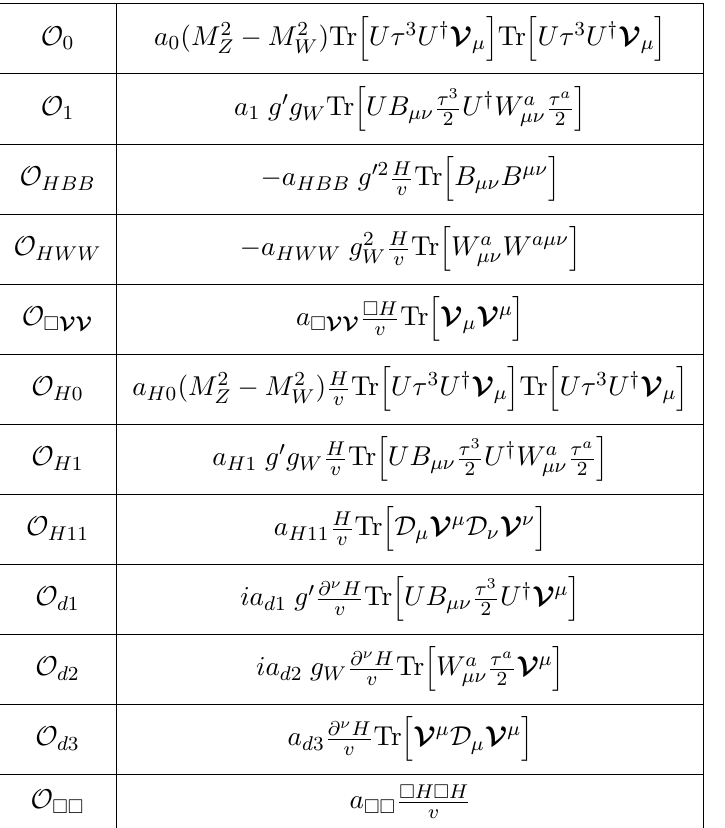
Table 1 . HEFT operators O i required for the cancellations of divergences, a i are the